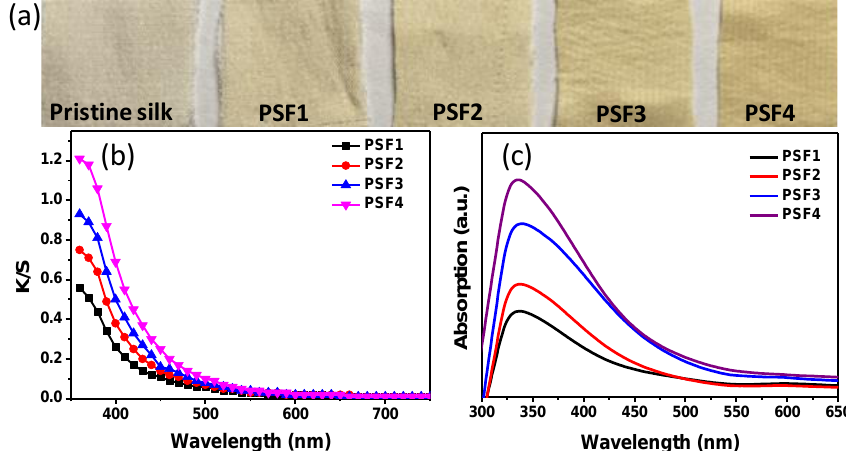
Figure 1. ( a ) Photograph, ( b ) K/S curves and ( c ) UV-vis diffuse reflective absorption spectra of the PtNP treated silk fabrics.